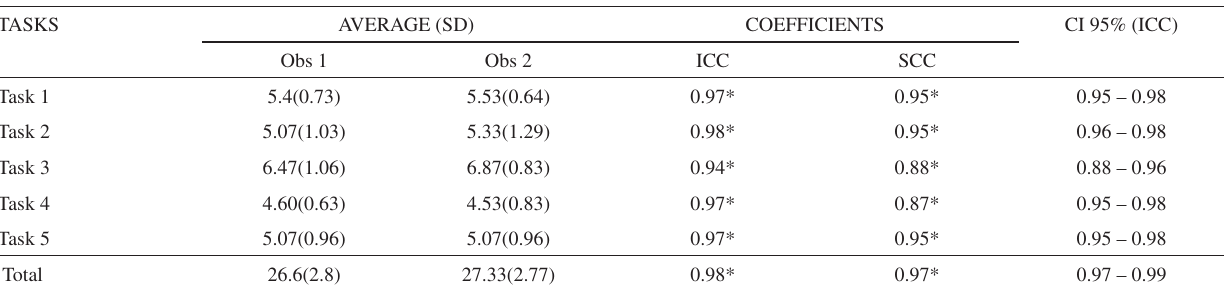
Table 2 - Inter-observer reproducibility according to Spearman’s correlation coefficient (SCC) and intra-class correlation coefficient (ICC)